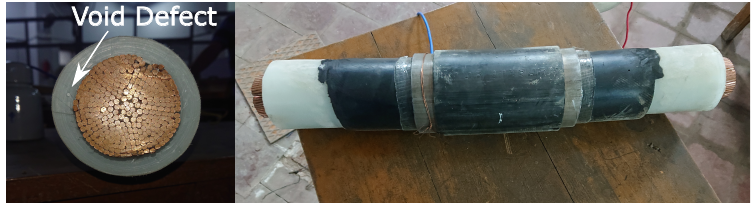
Figure 3. Tested 132 kV cable sample. The outer jacket, sheath, and semi-conductive screen were removed from the sides. A void in the radial direction of the cable was created.